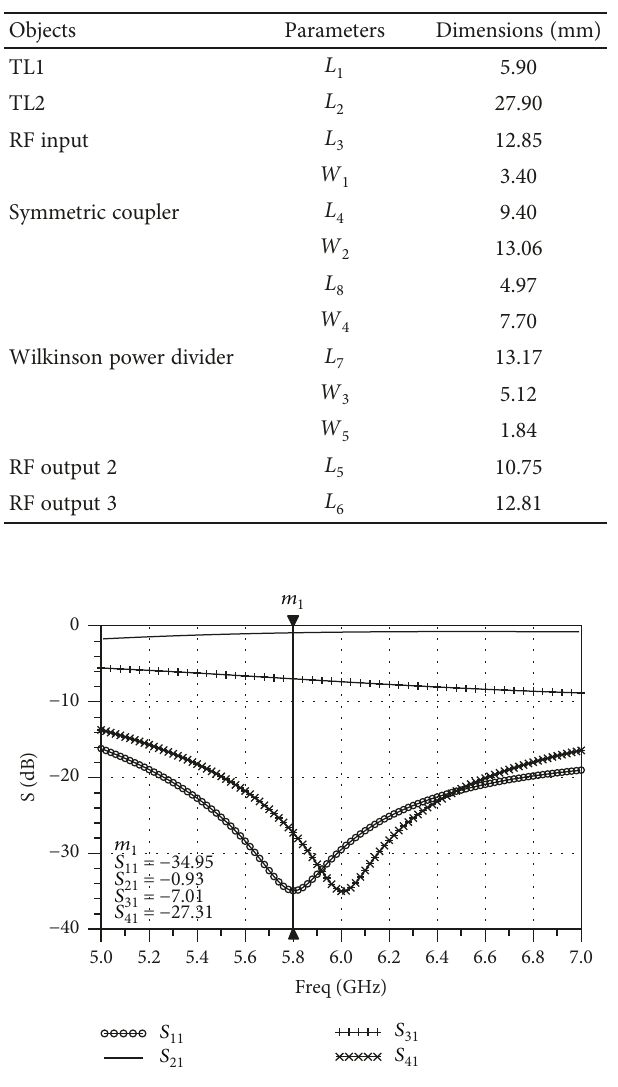
Figure 6: Amplitudes of the scattering parameters of the symmetric coupler simulated in ADS schematic with C = 7 dB.